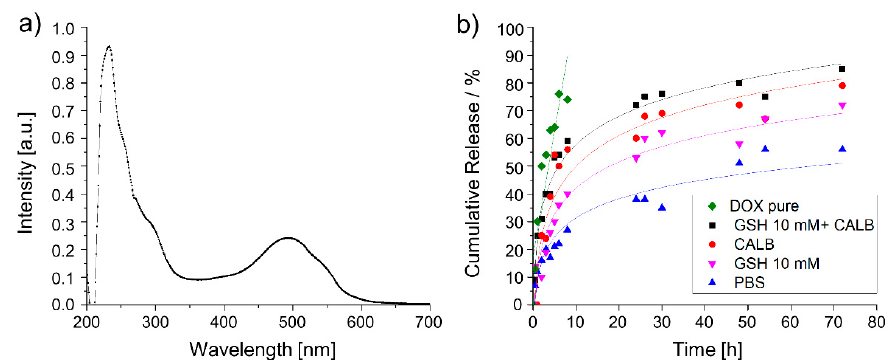
Figure 4. Determination and of drug loading content and subsequent release of DOX under reductive and/or enzymatic conditions. ( a ) UV/Vis spectrum of DR-dPGS@DOX; ( b ) release curve of DOX (linear fit), GSH+CALB, CALB, GSH, and PBS (Logarithmic Log3P1 fit).